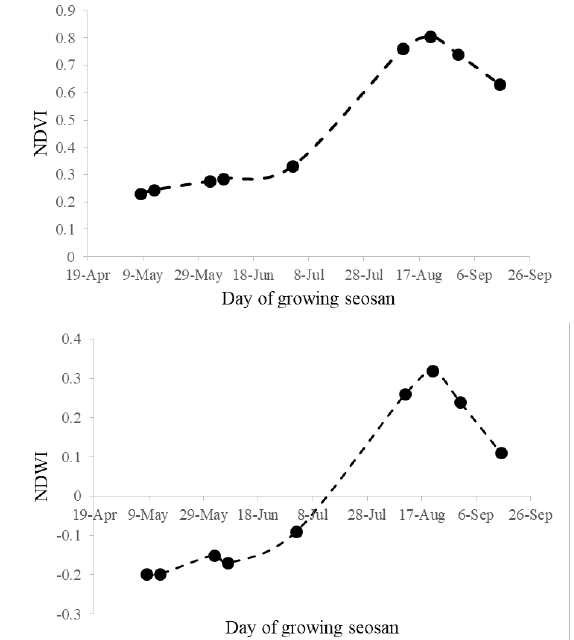
Figure 5. Times courses (a) NDVI and (b)